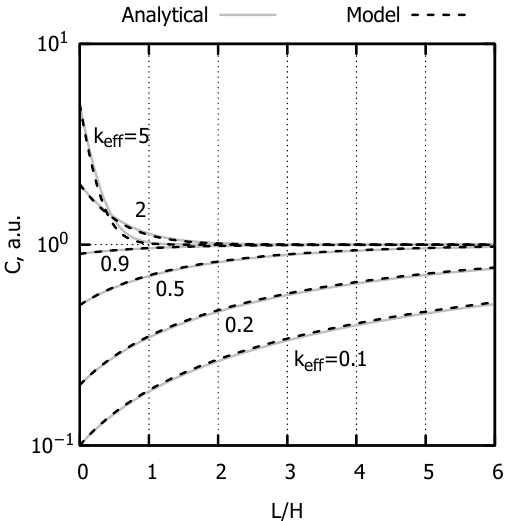
Figure A2. Comparison of model results with analytical formula for species concentration in the cylindrical crystal (without start and end cones) with different segregation coefficient values k eff ( L represents the crystal length, and H represents the height of the molten